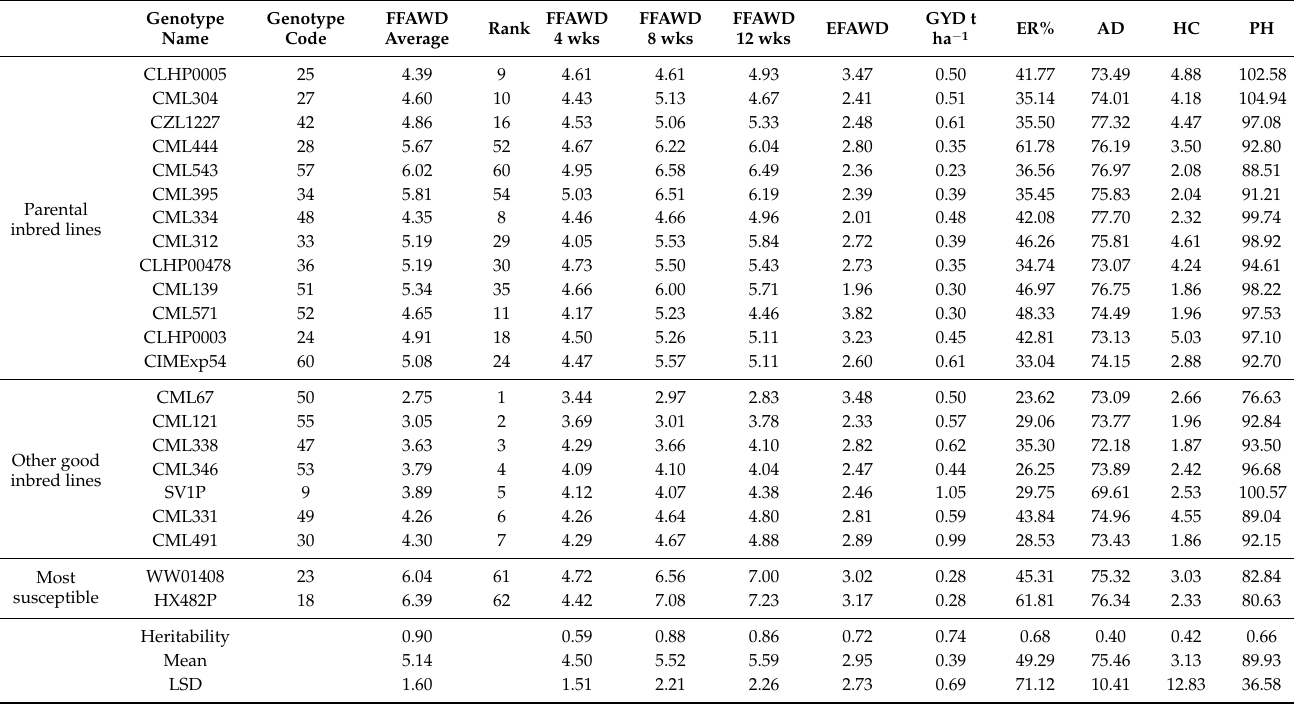
Table 7. Fall armyworm tolerance and grain yield performance of inbred parental lines of FAW resistant public commercial and experimental hybrids and other FAW resistant inbred lines evaluated under natural FAW infested sites in Zimbabwe during the 2019–2020